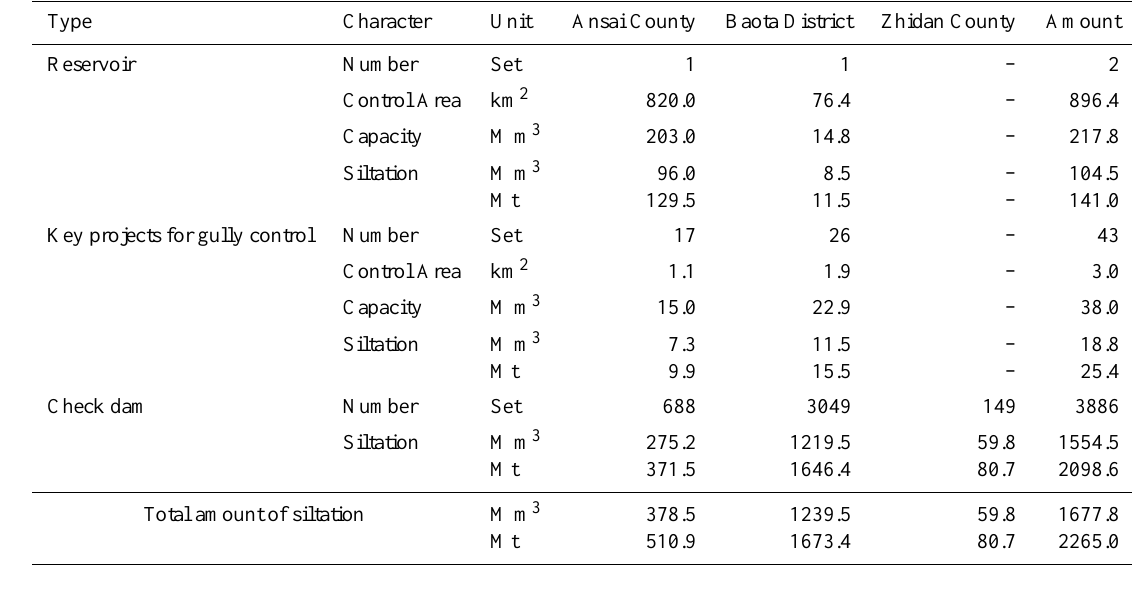
Table 6. Engineering measures of upstream area of GHS before 1999 (in ha).